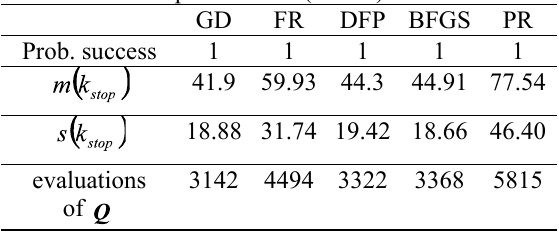
Table 4 – Ackley’s function ( n = 20 , RPOP) – no